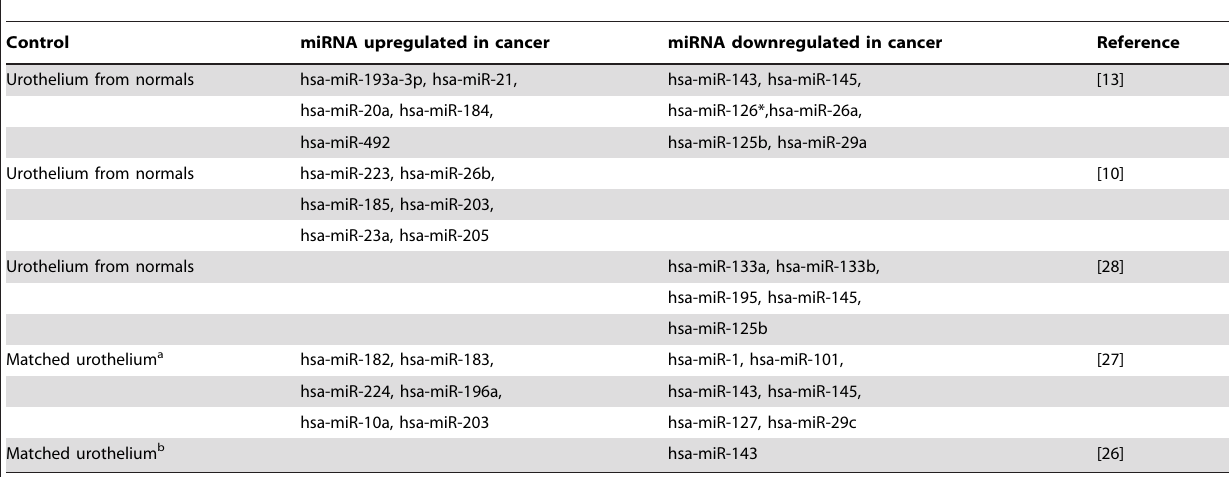
Table 2. Overlapping findings between published data and current